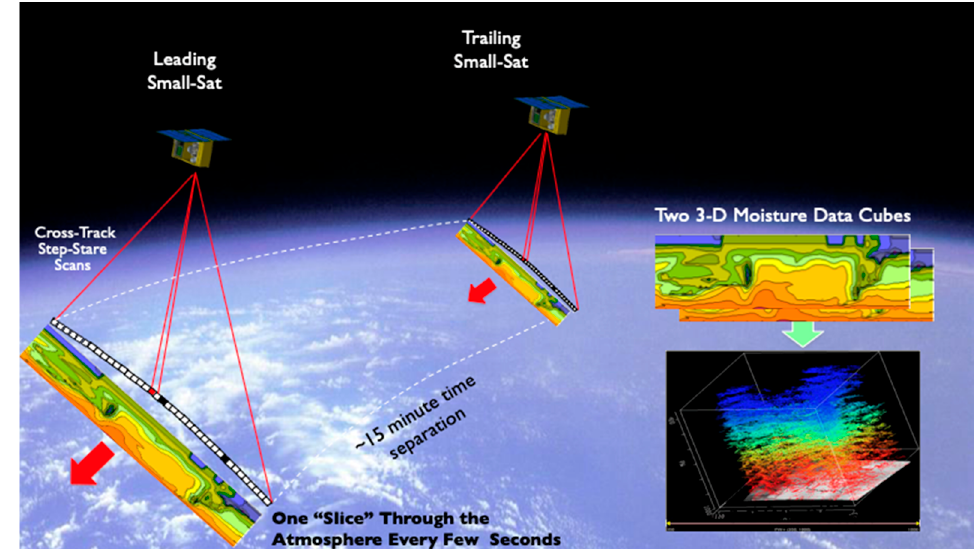
Figure 16. An artist’s conception of two time-separated satellites equipped with hyperspectral IR sounders that can provide moisture data cubes in the troposphere, resulting in winds at multiple pressure levels (lower right).